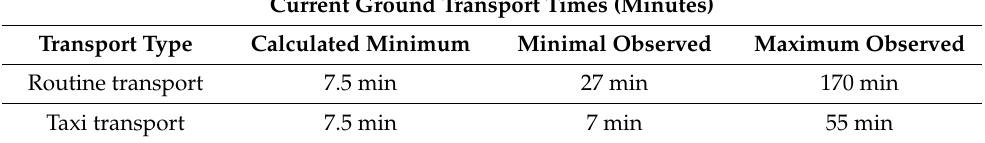
Table 2. Calculated minimum driving time from Ulleval University Hospital to the National Hospital with no delays. The minimal and maximum observed times are the actual times registered in our